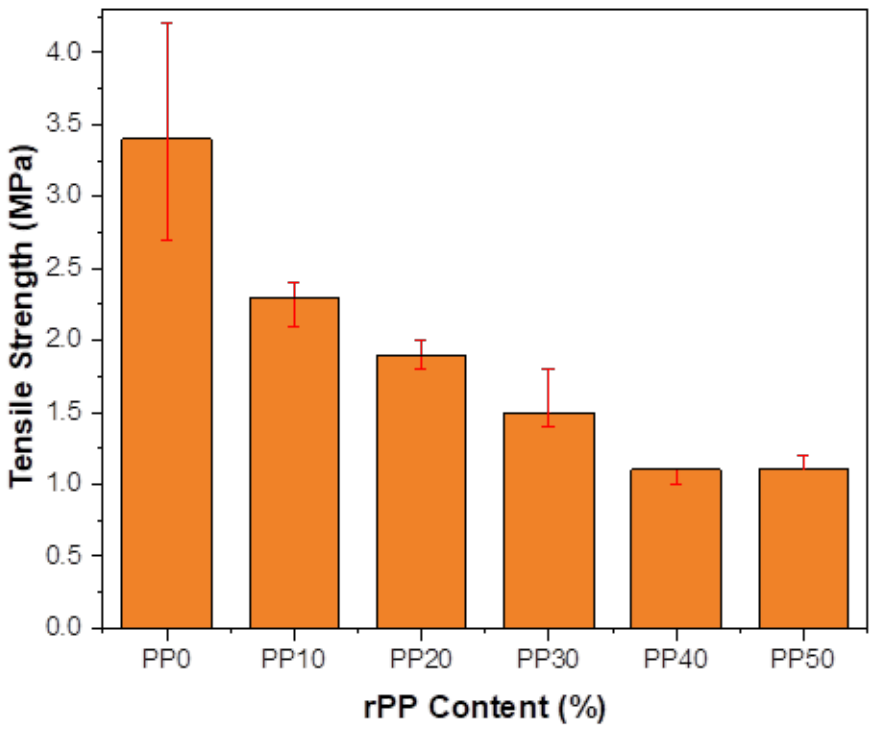
Figure 8. Tensile strength with different percentages of PP waste in mortar at the age of 28 days.